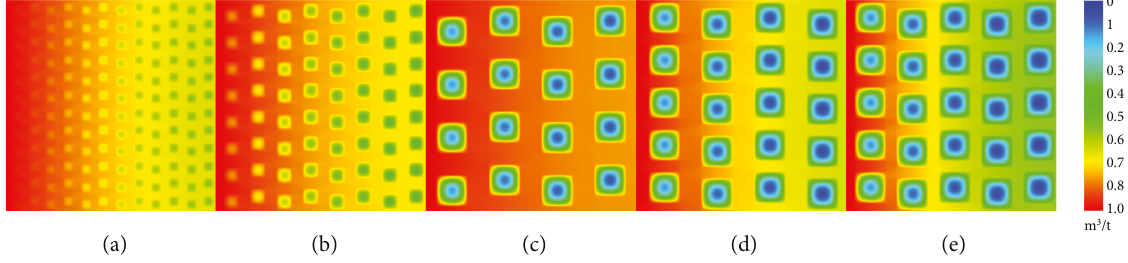
Figure 3: Results of the concentration distribution pro fi le for methane migration in porous media with adsorption under di ff erent porosities = 0 64 ), (b) G-2 ( S = 0 27 , ε = 0 64 ), (c) G-3 ( S = 0 13 , ε = 0 64 ), (d) G-4 ( S = 0 13 , and speci fi c surface areas, respectively. (a) G-1 ( S = 0 4 , ε f f f = 0 55 ), (e) G-5 ( S = 0 13 , ε = 0 44 ). The matrix porosity of the solid matrix is 0.1. ε f f